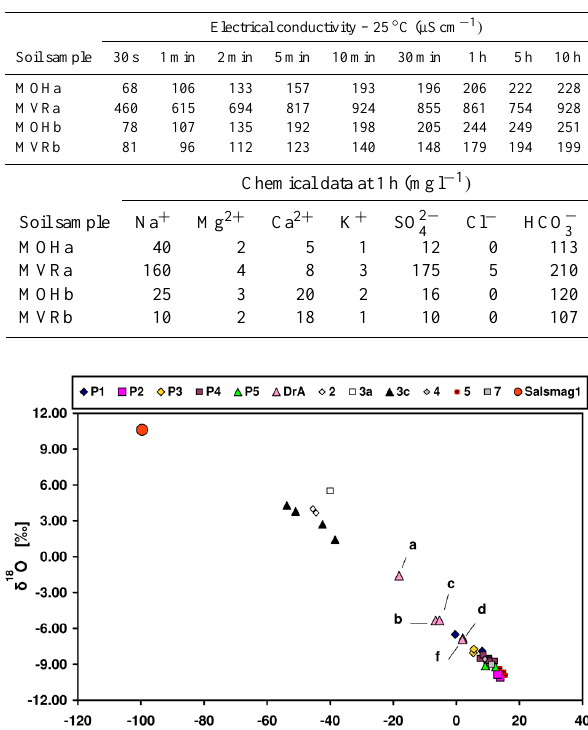
Table 4. Leaching results for the 4 soil samples collected. Chemical analyses for the 1h samples are also reported in mgl − 1 .